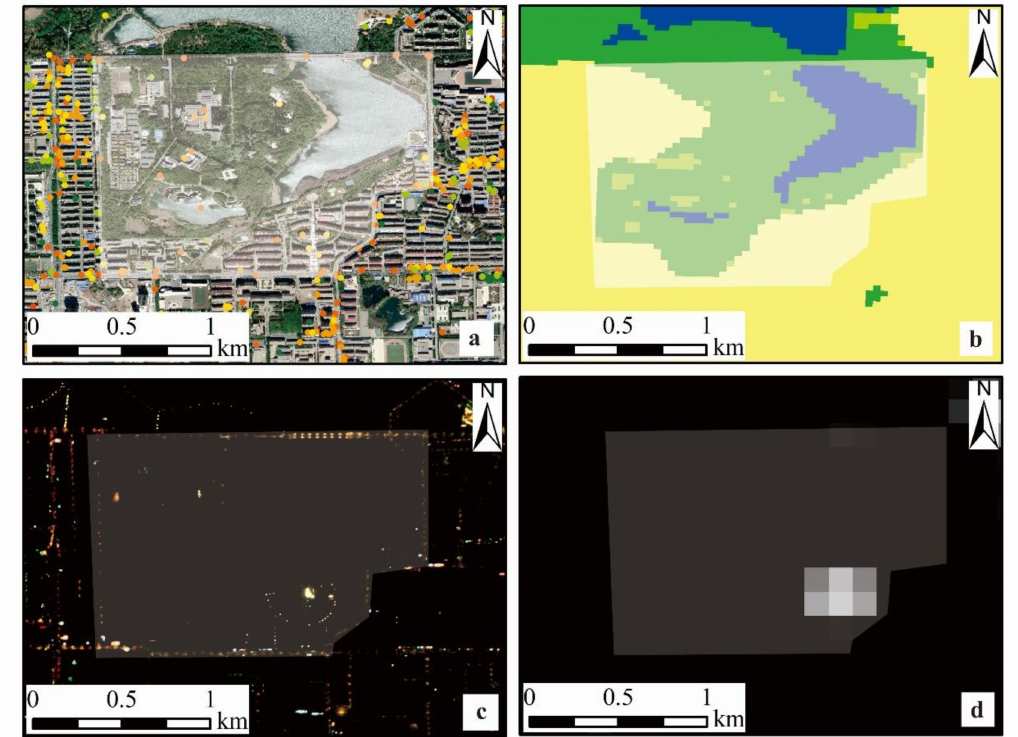
Figure 10. A sample of one of the parcels located in Nanhu Park superimposed on di ff erent types of features and NTL data: ( a ) POI superimposed on Google map image taken on May 6, 2018. Di ff erent colors represent the number of points of di ff erent POI types. ( b ) Land use. ( c ) JL1-3B. ( d ) Luojia 1-01. The shaded region represents the border of the parcel generated by